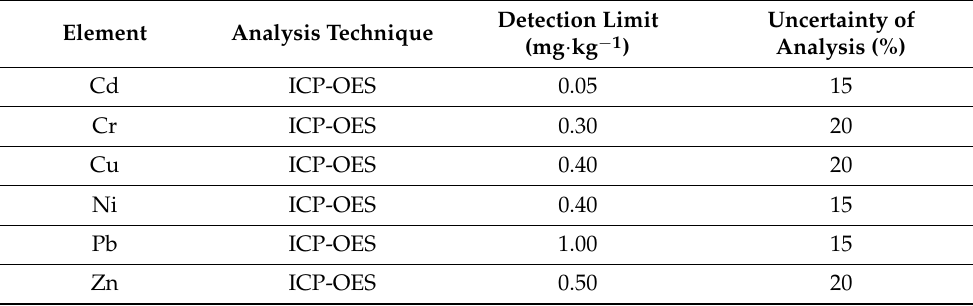
Table 1. Chemical analysis technique and qualitative results [89].